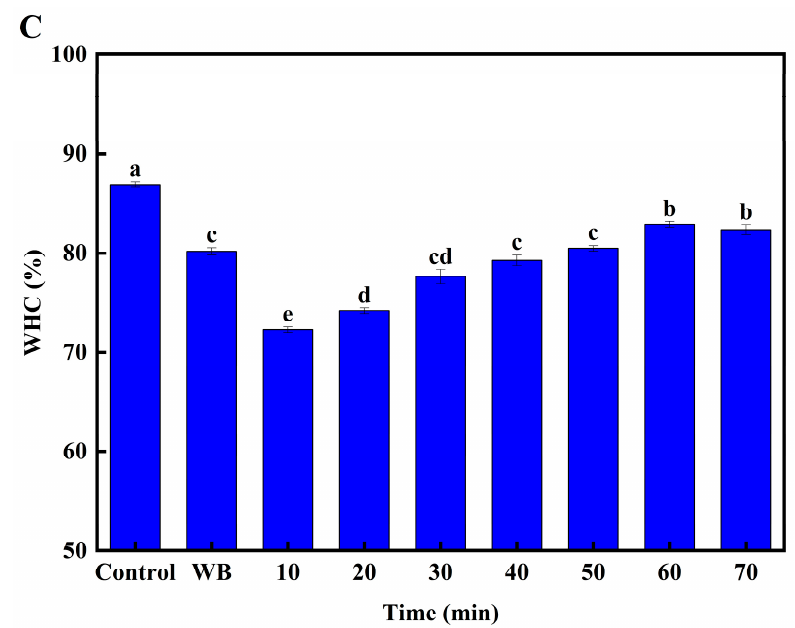
Figure 3. Effect of different DPCD treatments on the water holding capacity of surimi ( A ): Pressure, ( B ): Temperature, ( C ): Time. Different letters indicate statistically significant differences ( p < 0.05).